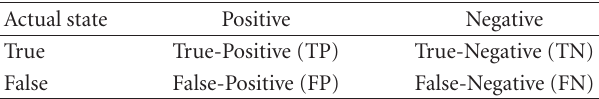
Table 1: Detection